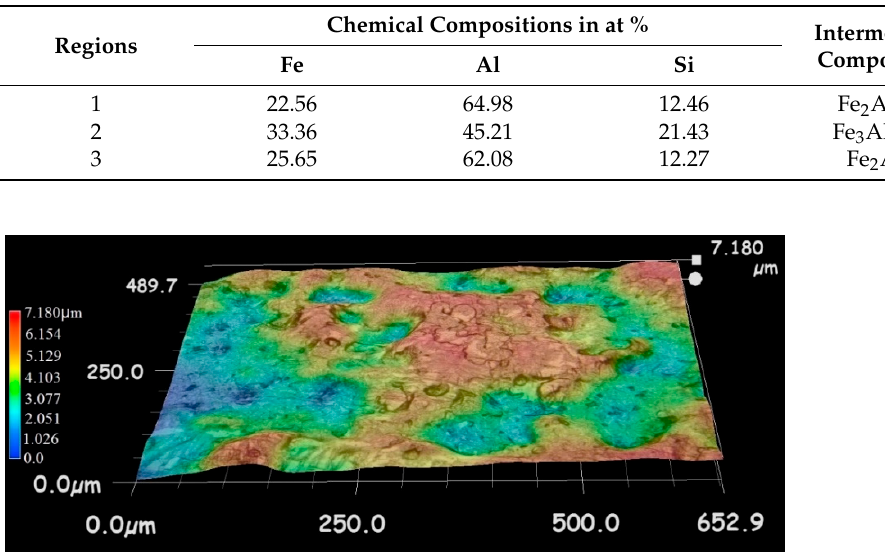
Figure 2. 3D surface topography of the hot-dipped Al–Si coating.